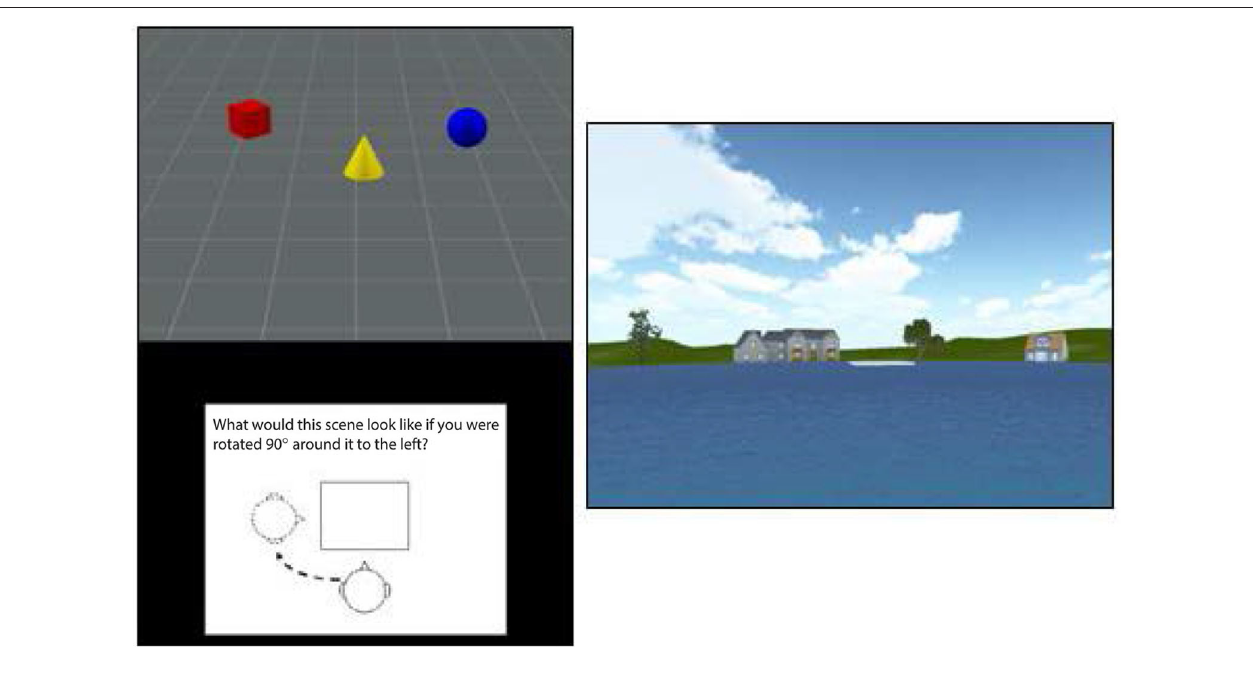
white in the center the pond image. The platform was visible on one-third of trials while it had to be reached from memory on the other two-thirds of